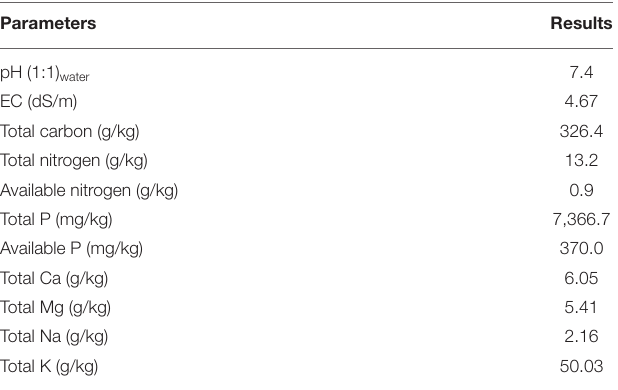
TABLE 4 | Effect of Bioplant on fresh and dry matter yields and N uptake of